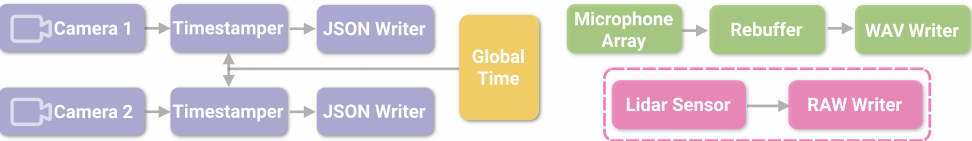
Figure 4. The sensor’s data acquisition pipeline is built using software blocks available in the REIP SDK. It contains separate tasks for each camera and the microphone array. The LiDAR data acquisition is performed on a separate machine (orchestrator laptop). Table 3. Dataset specifications after processing, featuring 3 data modalities (audio, video, and LiDAR) with synchronized